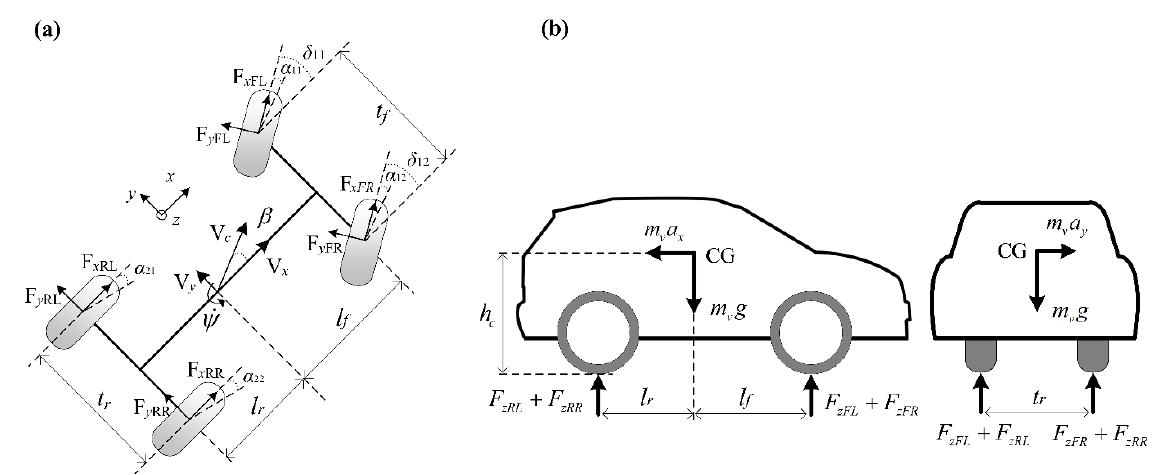
Figure 2. Schematic of 3-DOF vehicle model. ( a ) Vehicle planar model and ( b ) vehicle load transfer model.